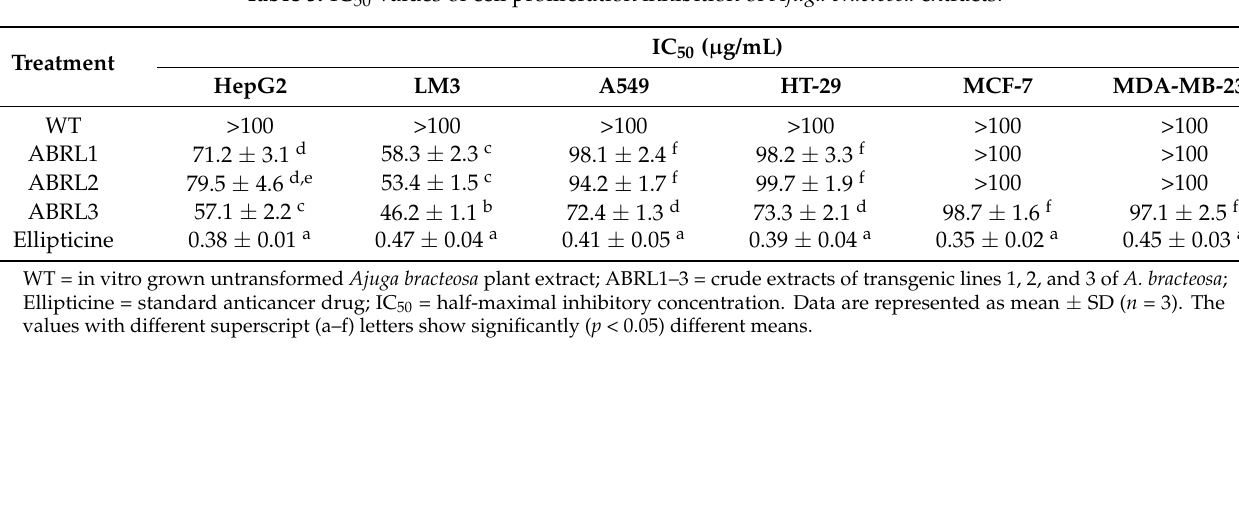
Figure 5. Cytotoxic activity of Ajuga bracteosa against ( a ) HepG2, ( b ) LM3, ( c ) HT-29, ( d ) A549, ( e ) MCF-7, and ( f ) MDA-MB-231. WT = wild type untransformed A. bracteosa plants; ABRL1–3 = transgenic lines 1–3 of A. bracteosa . Each value represents mean ± SD ( n = 3). * p < 0.05, ** p < 0.01, and *** p < 0.001 are statistically significant data. The IC 50 values of WT and transgenic lines of A . bracteosa against selected cell lines are represented in Table 5. Among all the tested samples, ABRL3 showed the low- est IC 50 of 57.1 ± 2.2 µ g/mL, 46.2 ± 1.1 µ g/mL, 72.4 ± 1.3 µ g/mL, 73.3 ± 2.1 µ g/mL,